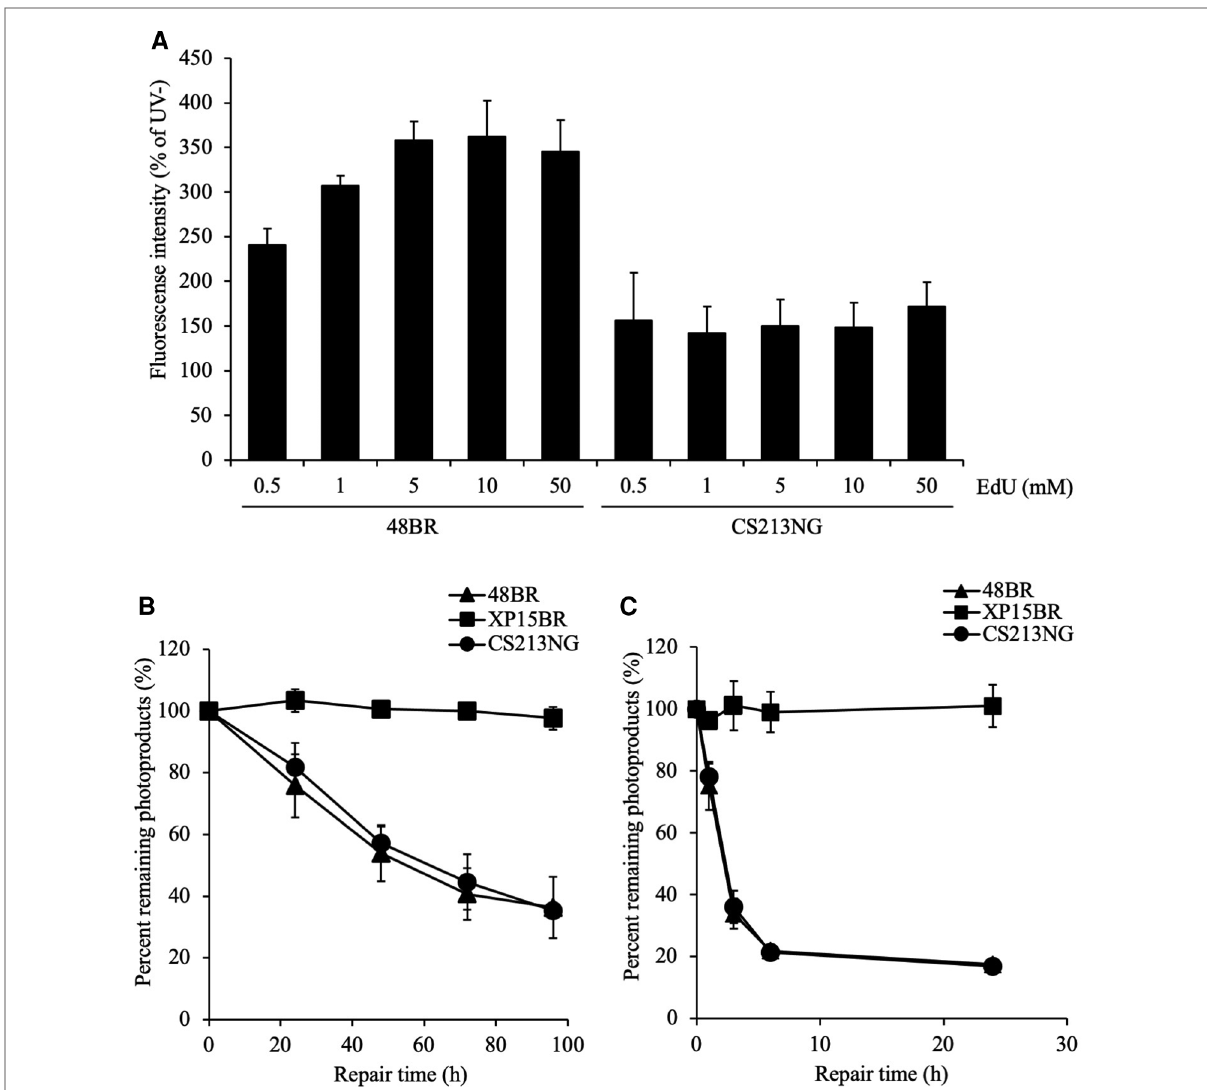
FIGURE 3 Reduced UDS in CS213NG cells is associated with an increased dNTP pool size. ( A ) A UDS assay was performed with various concentrations of EdU. 48BR and CS213NG cells were incubated with increasing EdU concentrations from 0.5 to 50 μ M. Error bars represent the SD of means of